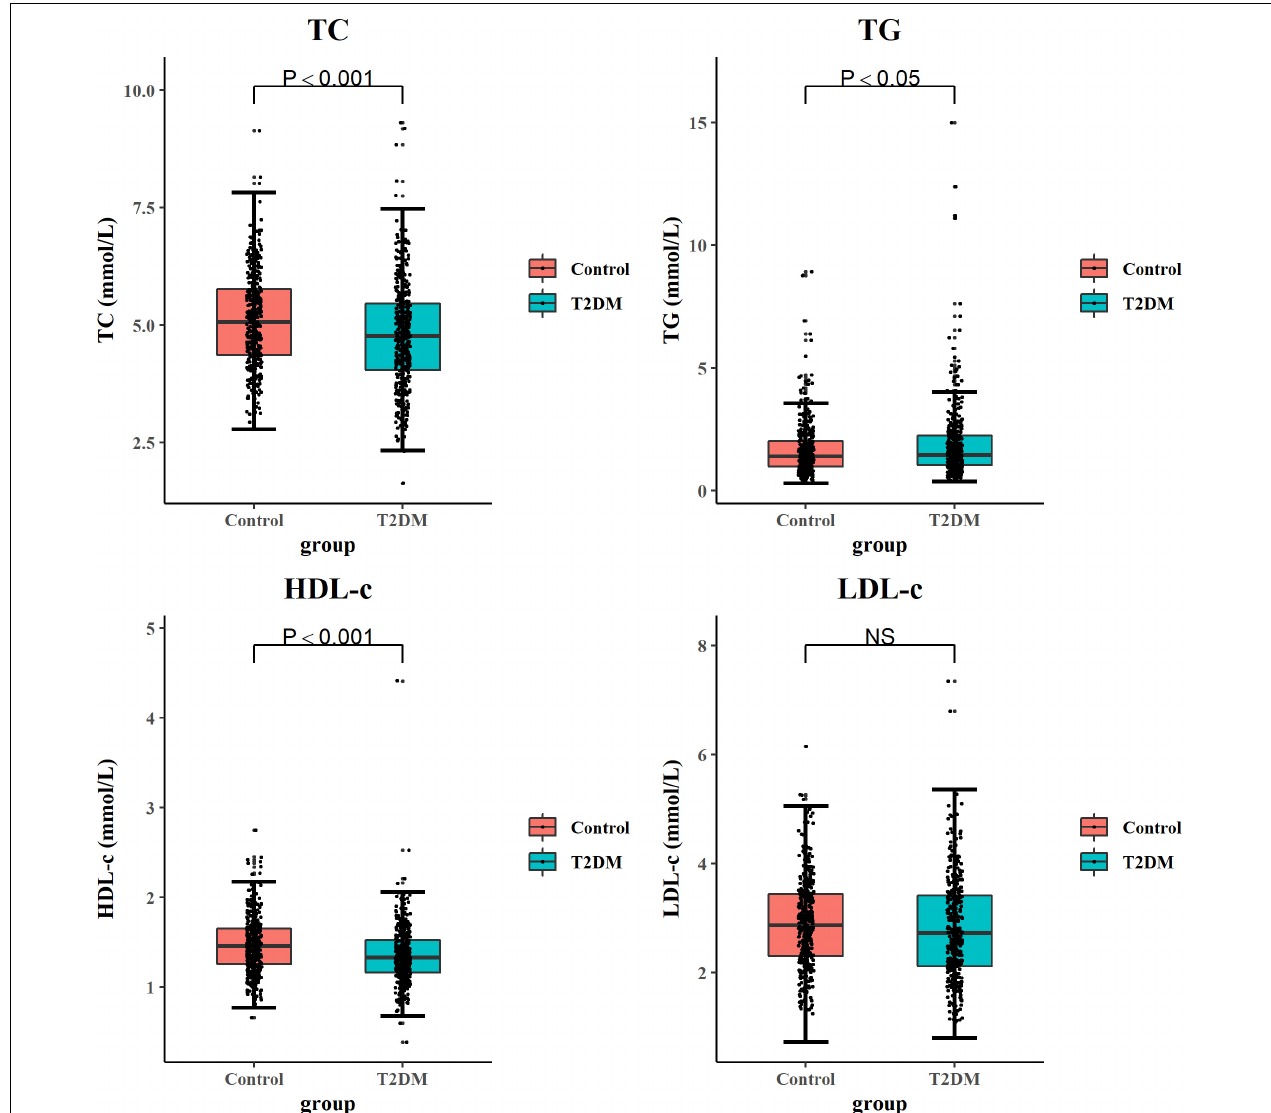
FIGURE 2 | Comparison of serum lipid levels in subjects with T2DM and control subjects. The GLM method was applied to analyze the difference of serum lipids between groups. Box plots showed each serum lipid level in subjects with T2DM and control subjects. While comparing serum lipid parameters, confounding factors including BMI, physical activity, CVA, CKD, eating fish oil supplements, APOE genotype, smoking, and drinking alcohol were adjusted. Significant differences between the two groups are indicated by P- value (two-sided) or NS. The boxes represent the 25th, 50th (median), and 75th percentiles of the data; the whiskers show the lowest (or highest) datum. GLM, general linear model; NS, no significance; BMI, body mass index; CVA, cerebrovascular accident; CKD, chronic kidney disease; APOE,